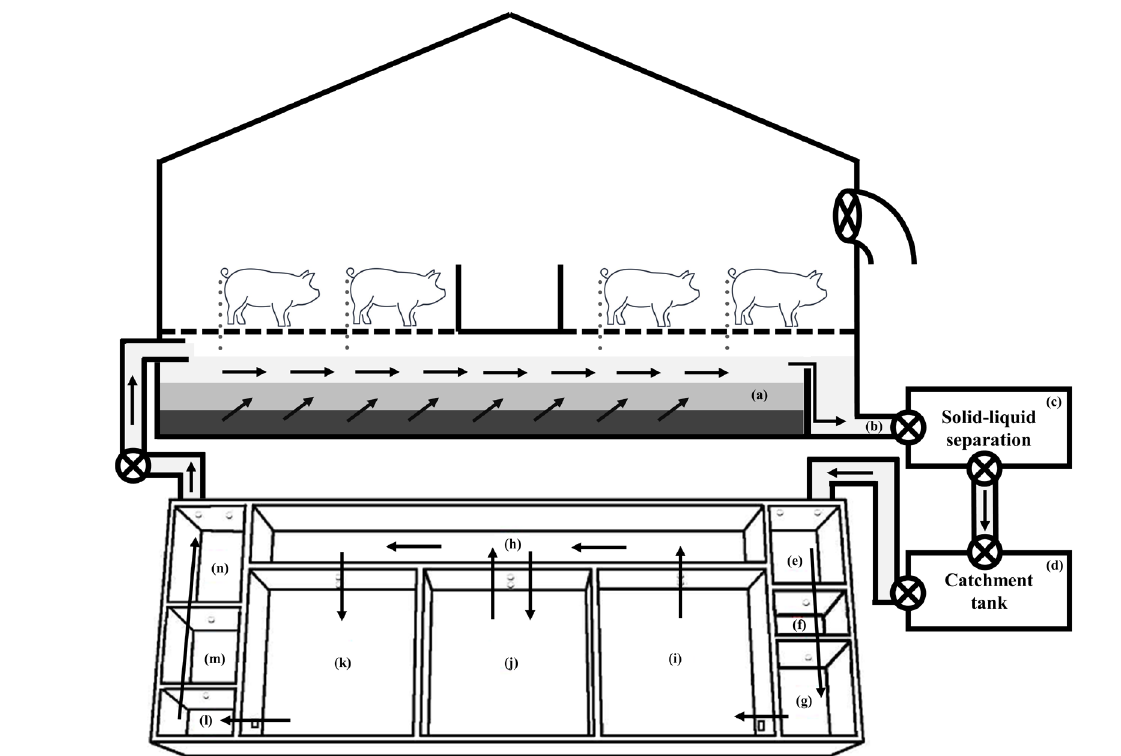
Figure 4. Schematic diagram of the experimental farm facilities with a continuous pit recirculation system and the auto thermal mesophilic aero- bic digestion facility. (a) pit mixing; (b) slurry outlet; (e) slurry tank; (f) flow control tank; (g) inlet tank; (h) first aeration tank; (i) anoxic (first and second); (j) second aeration tank; (k) third aeration tank; (l) first settling tank; (m) second settling tank; (n) circulation